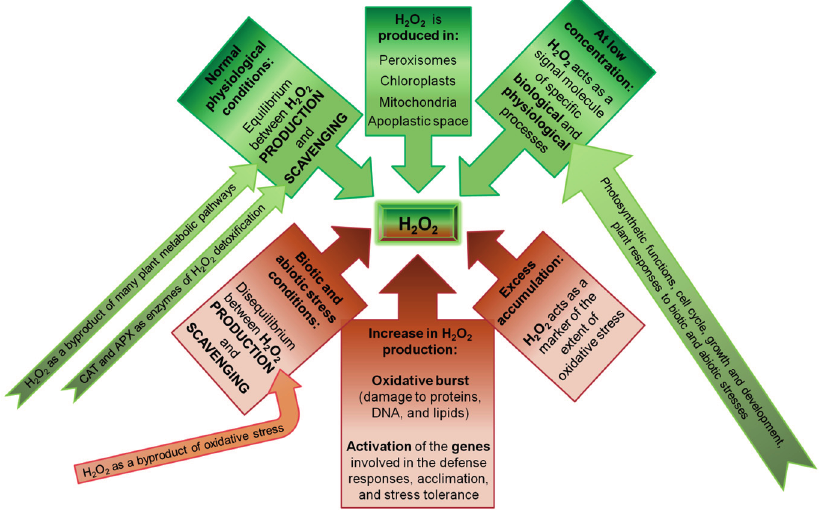
Figure 5. Role of the H 2 O 2 under normal physiological conditions (above, indicated with green color), and under stress conditions (below, indicated with brown